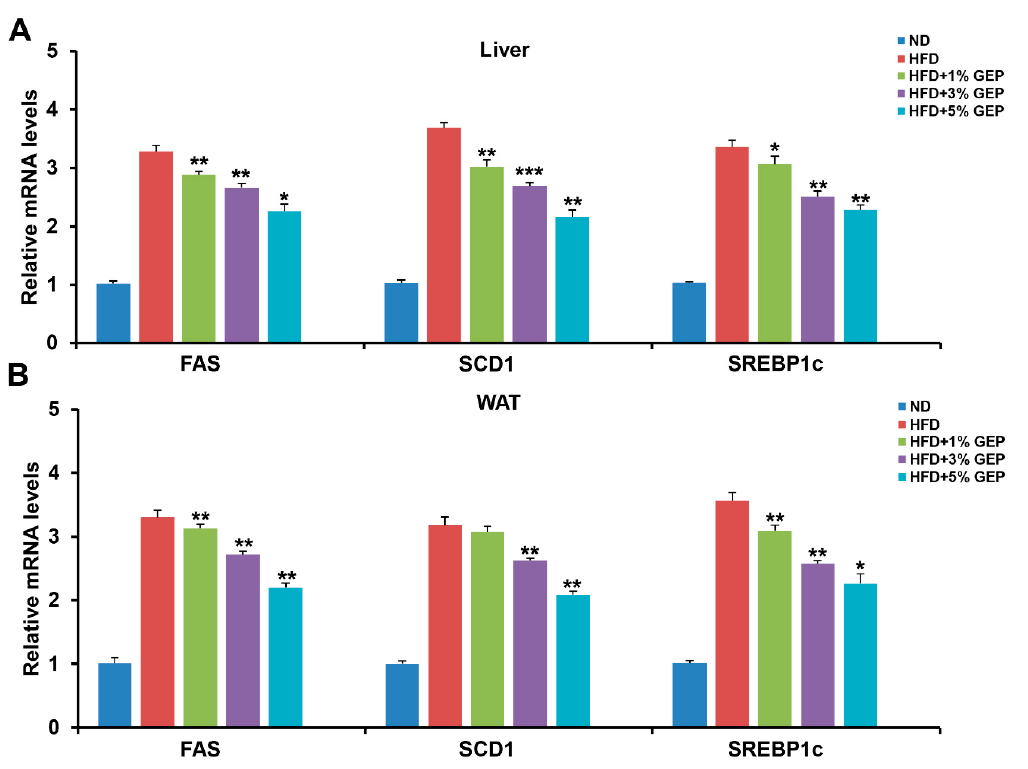
Figure 7. GEP treatment improved the mRNA expression of the lipogenesis-related genes FAS, SCD1, and SREBP1c. mRNA expression of lipogenesis-related genes in ( A ) the liver and ( B ) WAT measured using qRT-PCR. The mRNA levels were normalized to 18s rRNA. Data represent the mean ± SD of six to seven individual mice. Significant differences vs. the HFD group (control) were determined by one-way ANOVA; * p < 0.1, ** p < 0.01, *** p < 0.001. ND: normal chow diet group; HFD: high-fat diet group; HFD + GEP: high-fat diet and Ganoderma lucidum extract powder.